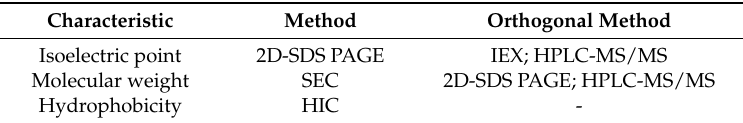
Table 2. Analytical methods used for the characterization of HCP.